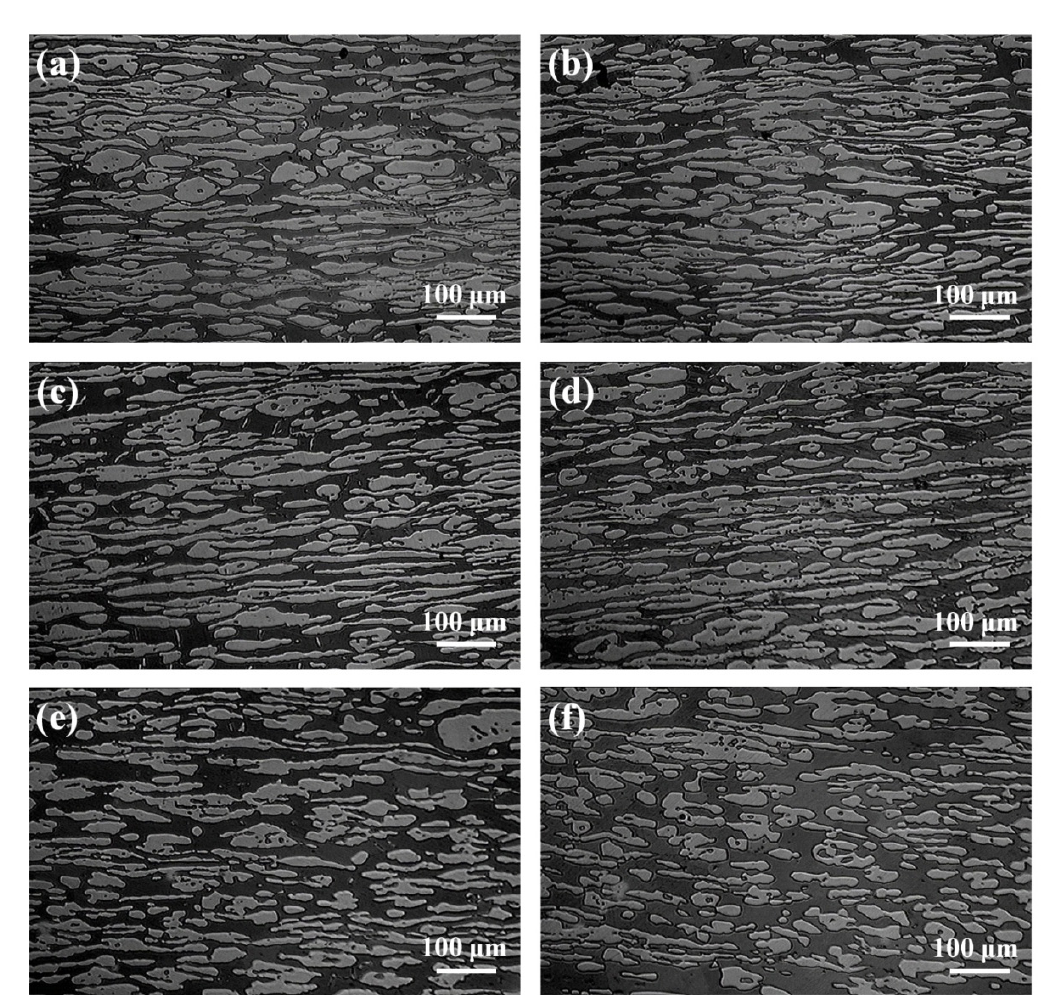
Figure 2. Optical micrographs of specimens annealed at different temperature for 30 min, the dark area representing ferrite while the light representing austenite. ( a ) 1000 °C; ( b ) 1020 °C; ( c ) 1050 °C; ( d ) 1080 °C; ( e ) 1110 °C; ( f ) 1150